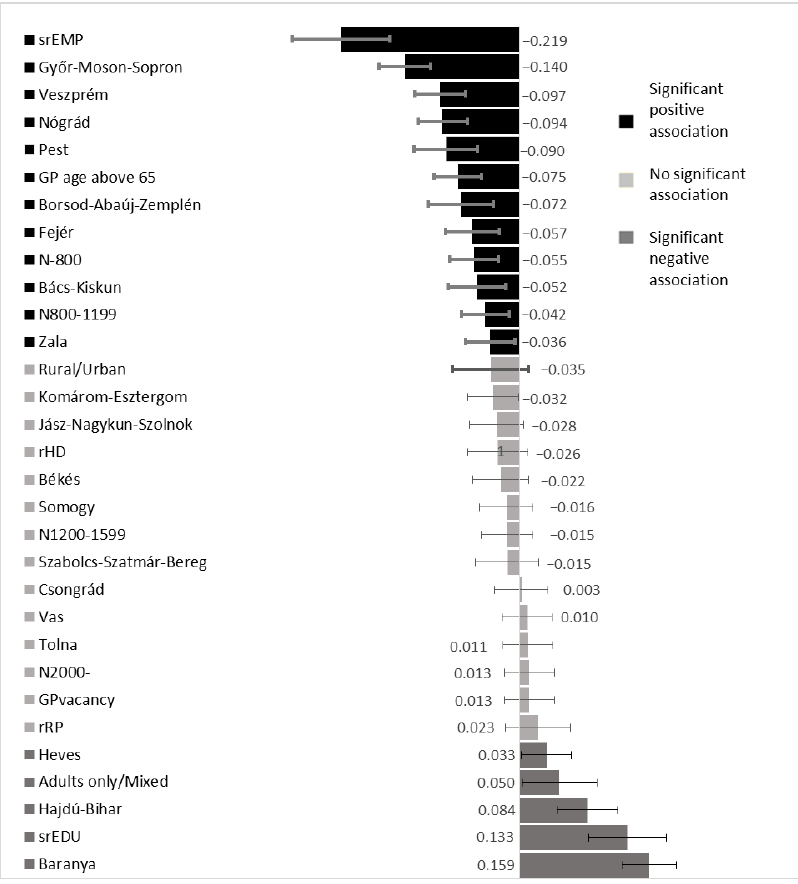
Figure 2. Strength of the association between socioeconomic factors, including Roma population proportion, and GMP-specific structural indicators with average per-capita GMP-specific expenditures of the National Health Insurance Fund based on the standardized linear regression coefficients from multivariate regression model. (srEMP: normalized standardized employment ratio, rHD: normalized relative housing density, srEDU: normalized relative education, rRP: normalized Roma proportion, N: number of patients at each GMP with reference N1600−1999 Budapest as the reference for counties).